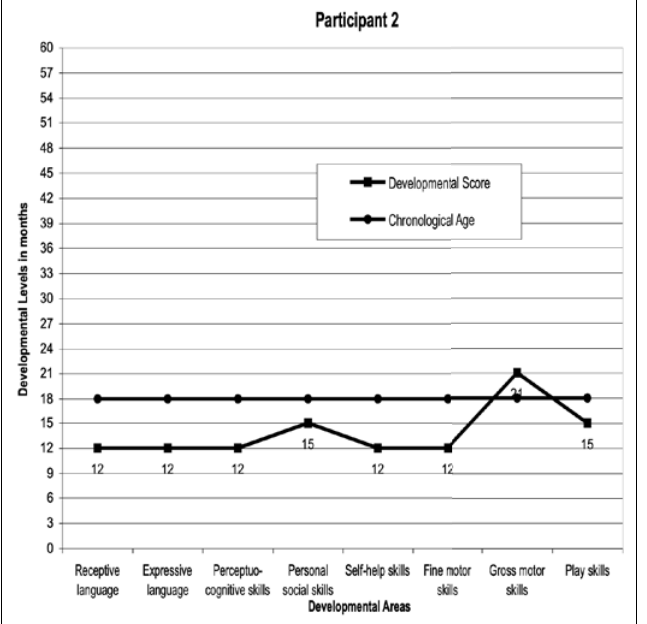
Fig. 2. Participant 2: Comparison between chronological age and developmental level of functioning.